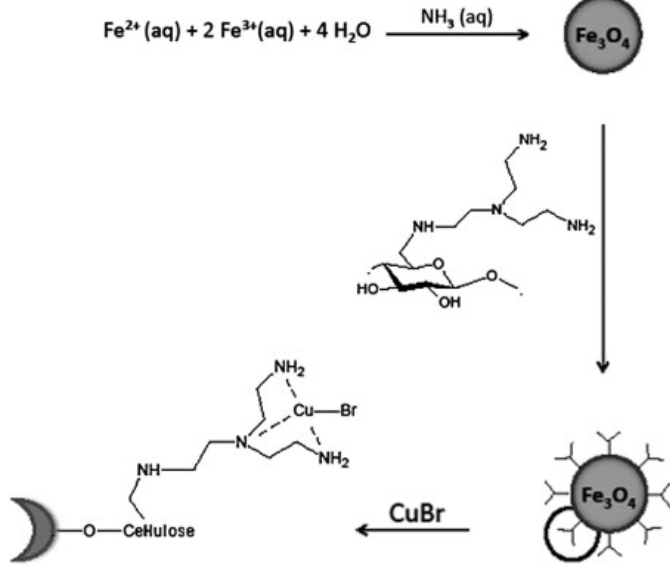
Figure 2. Synthesis of Fe Heinze et al. [49]. Copyright 2013 with permission of